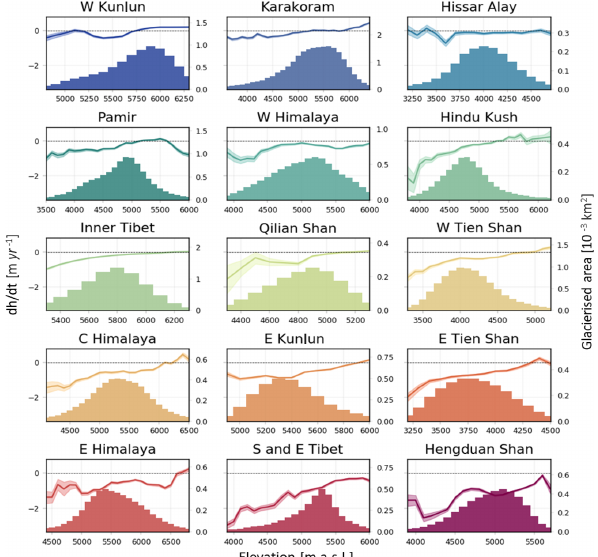
Figure 6. Altitudinal distribution of elevation changes and glacier hypsometry functions in High Mountain Asia (HMA) in RGI 6.0 sub-regions between 2010 and 2019. The lines show elevation change rates with uncertainty envelopes plotted against 100m el- evation bands (left y axis). The bars display the glacier hypsometry (right y